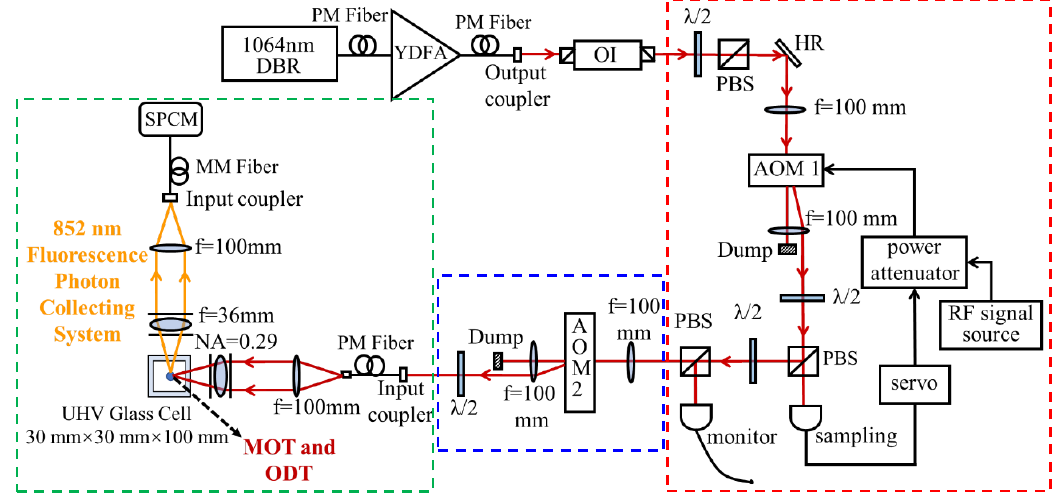
Figure 5. Experimental setup. Polarization-maintaining (PM) fiber; Multi-mode (MM) fiber; magneto-optical trap (MOT); optical-dipole trap (ODT), otherwise the optical tweezer; optical isolator (OI); acousto-optical modulator (AOM); polarization beam splitter (PBS); single-photon counting module (SPCM); ultra-high vacuum (UHV). The red dash box shows the laser intensity fluctuation feedback loop by controlling the diffraction efficiency of AOM 1 to stabilize the intensity fluctuation of the 1064-nm laser. The blue dash box shows the measurement setup of the trap frequency of optical tweezer. The green dash box shows the single-atom cooling and trapping system, the anti-Helmholtz coils, but the cooling and repumping laser beams of the MOT are not shown here.